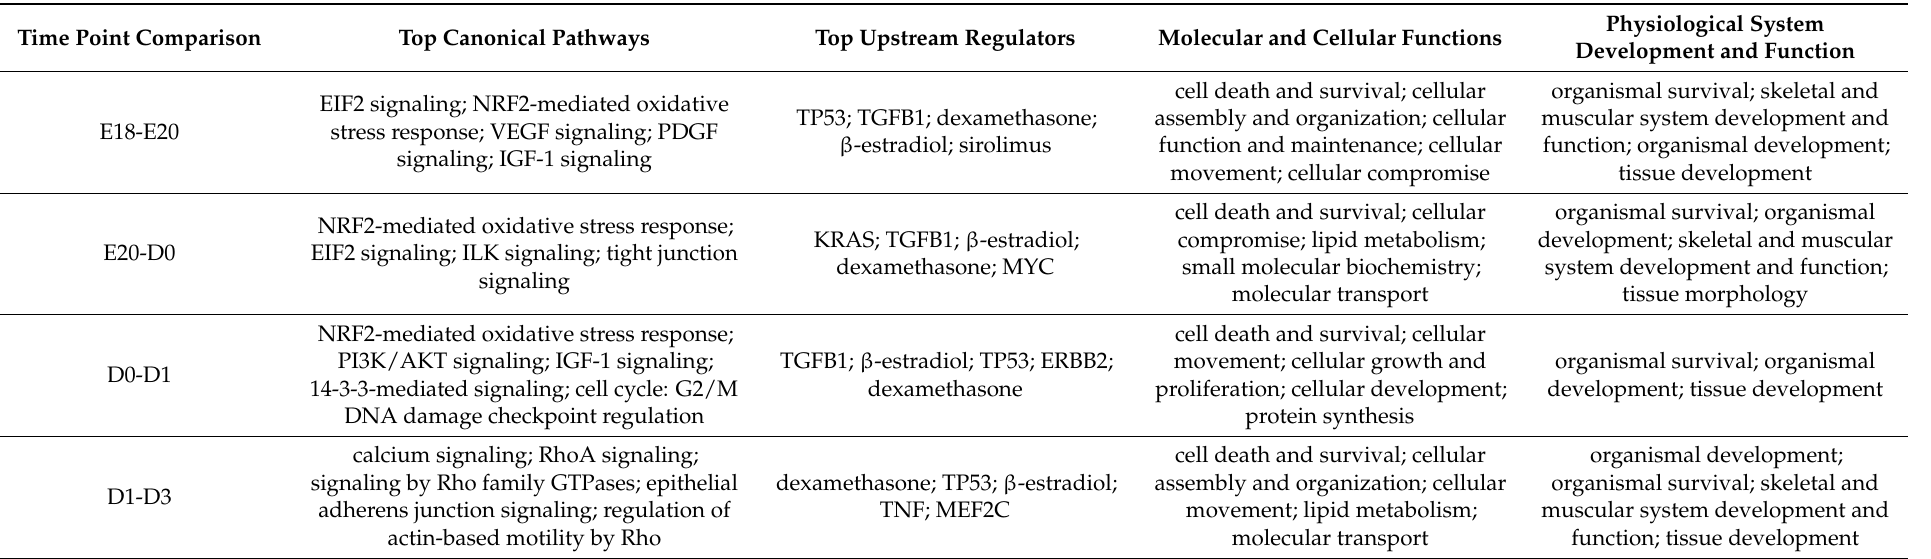
Table 1. Top cellular pathways and functions associated with chicken adipose tissue during the embryonic to hatch